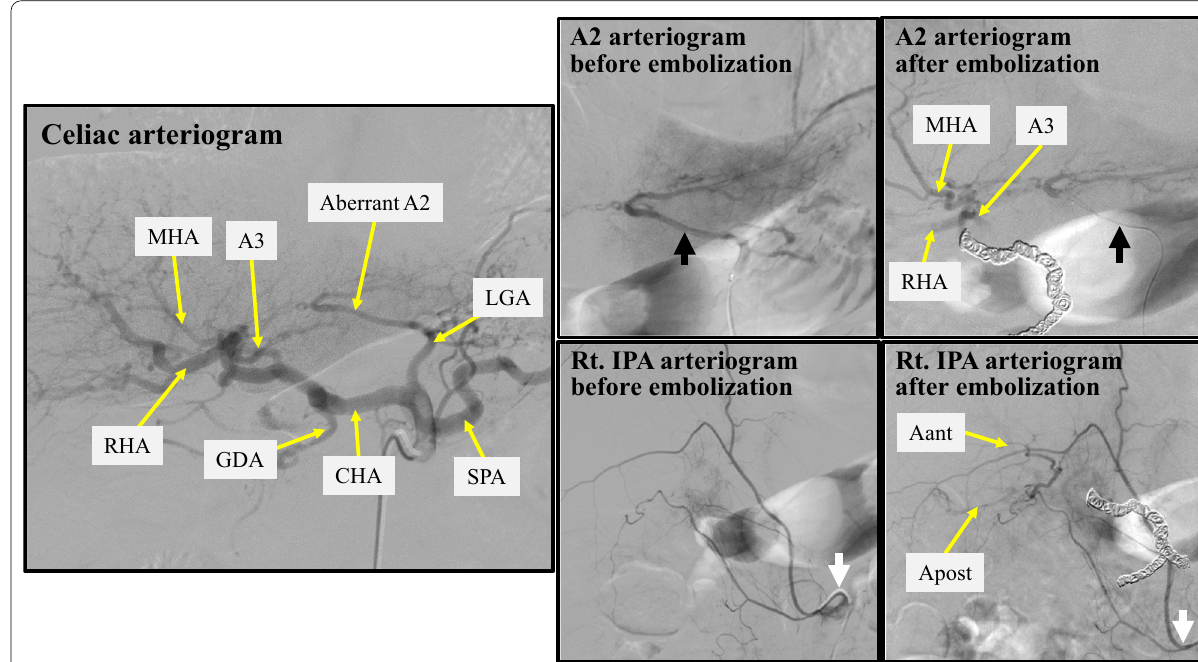
Fig. 3 Preoperative hepatic arterial embolization. Immediately after embolization, collateral arterial flow fed by the aberrant A2 (black arrow) and the Rt. IPA (white arrow) to the whole liver is observed. Aant, artery of the right anterior section of the liver; Apost, artery of the right posterior section of the liver; A2, artery of liver segment 2; A3, artery of liver segment 3; CHA common hepatic artery, GDA gastroduodenal artery, LGA left gastric artery, MHA middle hepatic artery, RHA right hepatic artery, SPA splenic artery, Rt. IPA right inferior phrenic artery